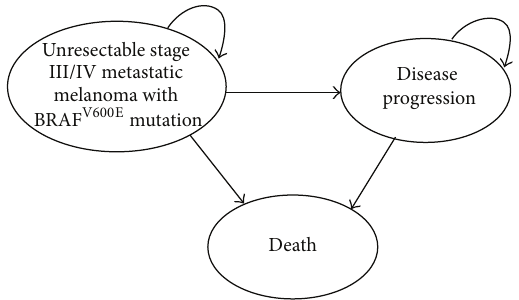
Figure 1: Markov structure diagramming progression of patients through health